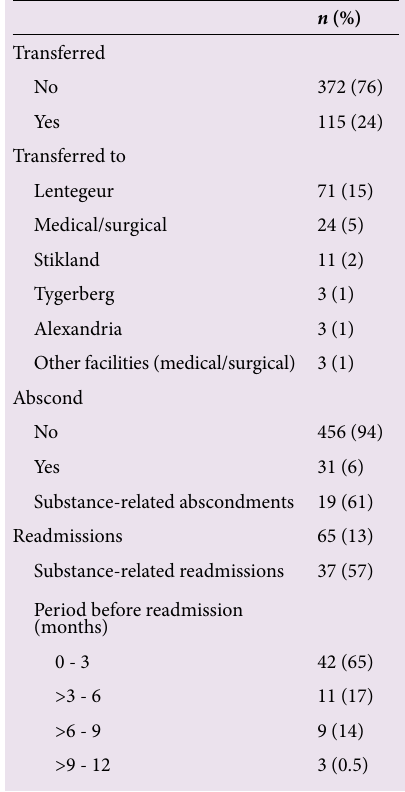
Table 1. Psychiatric diagnoses by gender for mental healthcare users (total admission episodes, N =487*) admitted to Helderberg Hospital, 2011 Diagnostic cluster